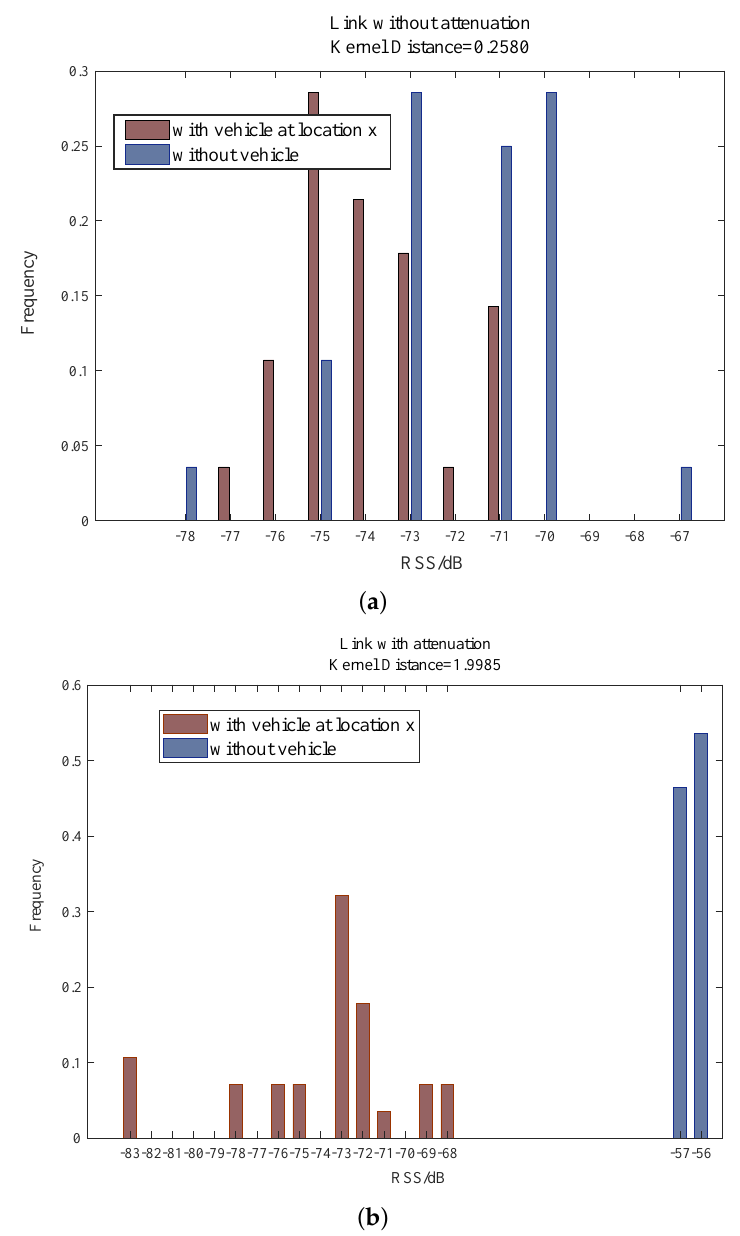
Figure 5. Thevalidationoftheselectionmethodfortheobscuredlinkbasedonkerneldistance. ( a )Thekernel distance of the unobscured link between the online phase and the offline phase. ( b ) The kernel distance of the obscured link between the online phase and the offline